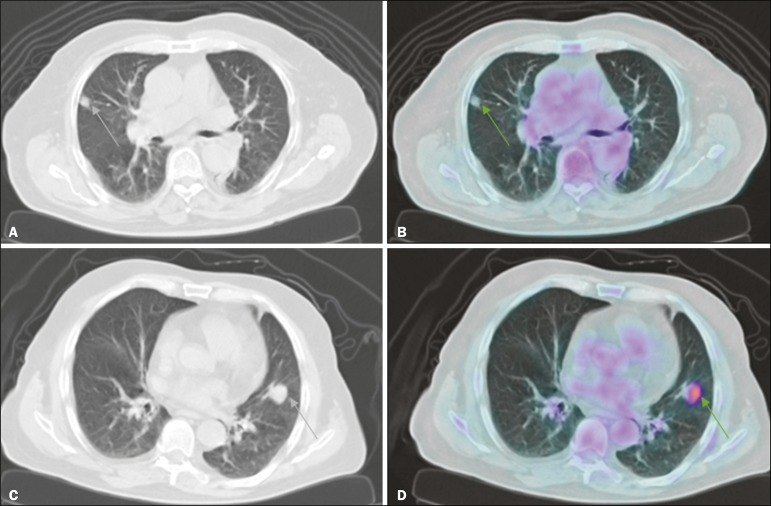
Examples of the use of 18F-FDG-PET/CT in SPNs. A: A nodule for which the probability of malignancy was 33.2% on the basis of clinical and CT findings, decreasing to 10% when the absence of 18F-FDG uptake was taken into account (a follow-up CT scan at two years out showed that the nodule had disappeared). B: A nodule for which the probability of malignancy was 6.2% on the basis of clinical and CT findings, increasing to 75.8% when the moderate 18F-FDG uptake was taken into account (a subsequent biopsy revealed an adenocarcinoma).